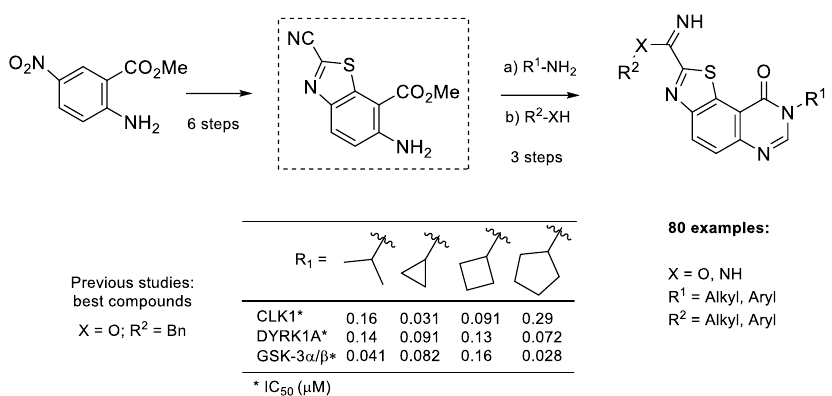
Figure 1. Results of molecular modeling studies (docking experiments) ( left ) and schematic representation ( right ) of the predicted binding modes of thiazolo[5,4- f ]quinazolin-9(8 H )-ones (Scheme 2, in